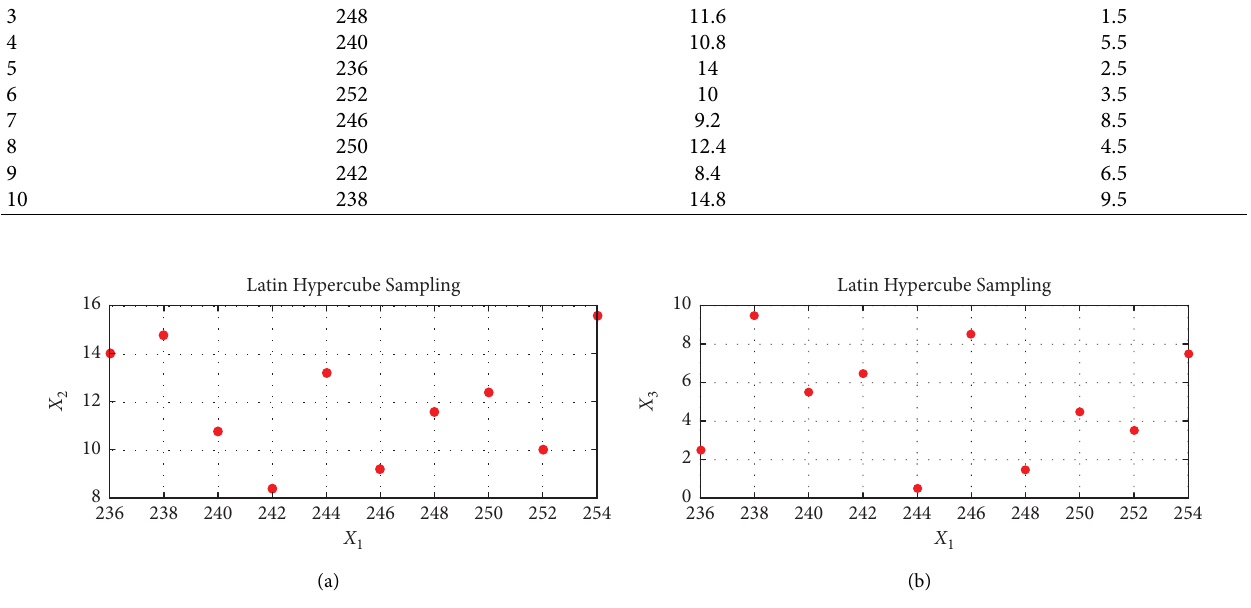
Figure 7: Latin hypercube